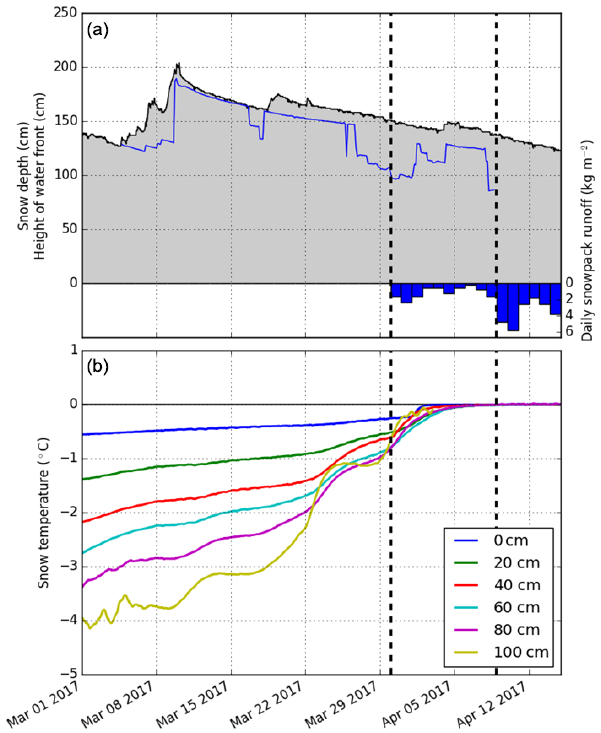
Figure 4. (a) Evolution of the snow depth (black line), height of the water front (blue line) and daily snowpack runoff (blue bars) from 1 March to 15 April 2017 at WFJ. (b) Measured snow temperatures at different heights above the ground are from the same period and same location. Dashed lines indicate 30 March and 9 April.